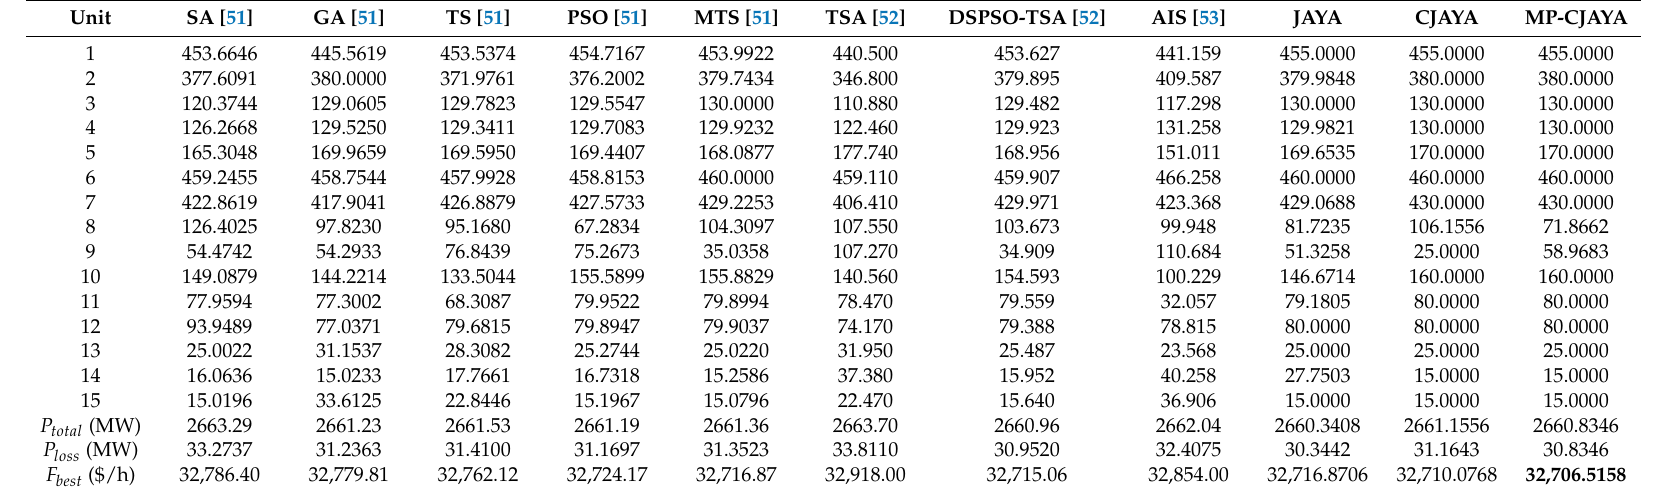
Table 7. Best outputs for 15-units system ( P D = 2630